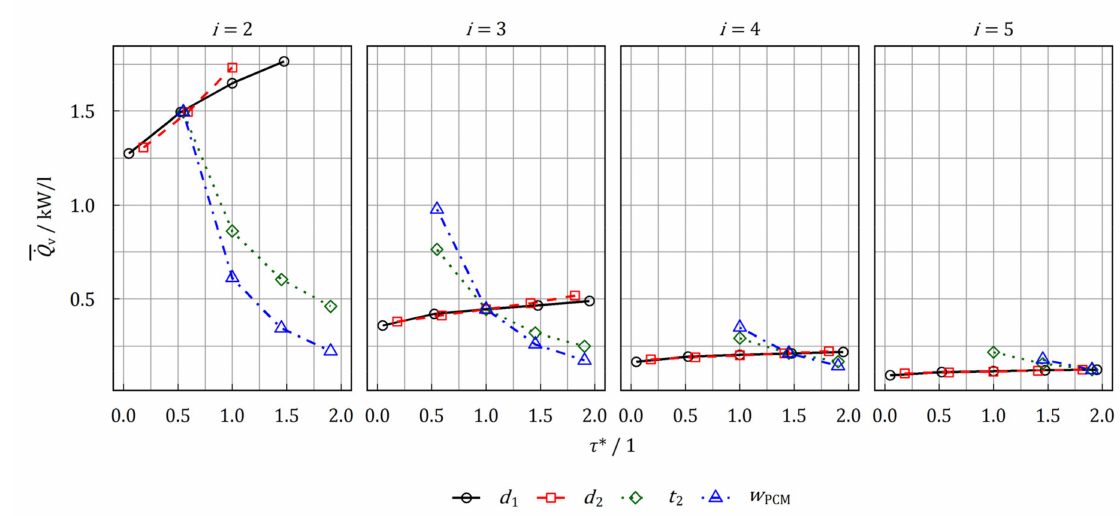
Figure 18. Mean volume specific power vs. τ ∗ for the geometry parameters d 1 , d 2 , t 2 and w PCM . The results for i = 1 are not shown as the range of the y -axis is too large for a